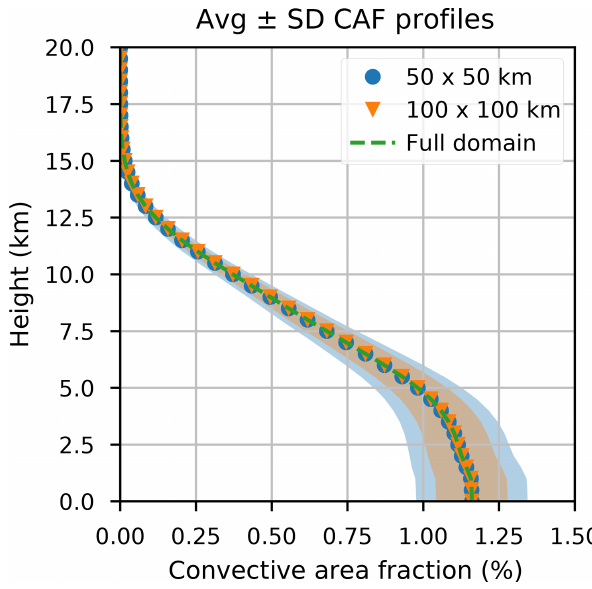
Figure 6. Dependence of the standard deviation of the frequency distribution of measured convective area fractions on the domain size of the CPOL radar. Shaded areas show the standard deviation for a domain size of 190 × 190km 2 (green), 100 × 100km 2 (red) and 50 × 50km 2 (blue). For the smaller domain sizes, the measurement domain of the radar has been divided into smaller subdomains. The shaded areas give the standard deviation. The green line shows the mean convective area